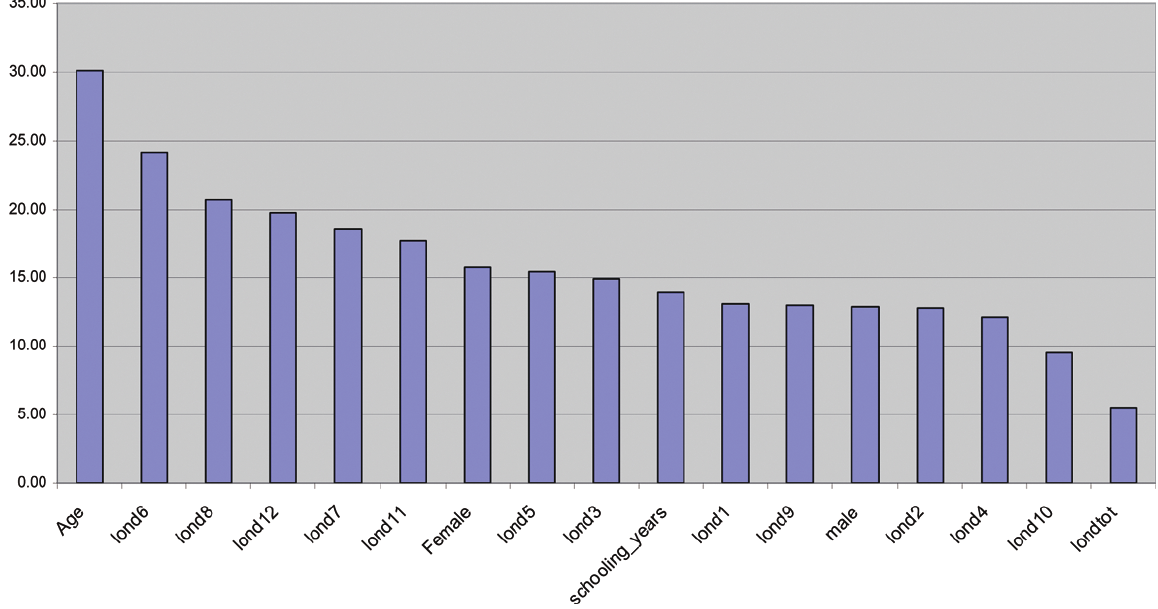
Fig. 3. Input relevance distribution of the variables in the neural network